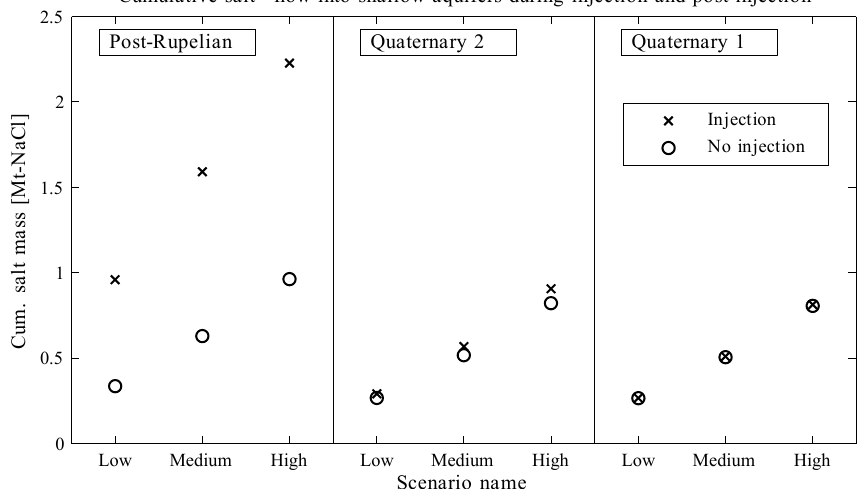
Figure 10. Scenario study 1: the cumulative salt flow for a period of 100 years (injection plus post-injection) into the Tertiary Post-Rupelian, the Quaternary 2, and the Quaternary 1 each for the low, medium, and high scenarios. The crosses correspond to simulations with injection, whereas the circles correspond to cases without injection, i.e., only the salt base flow.